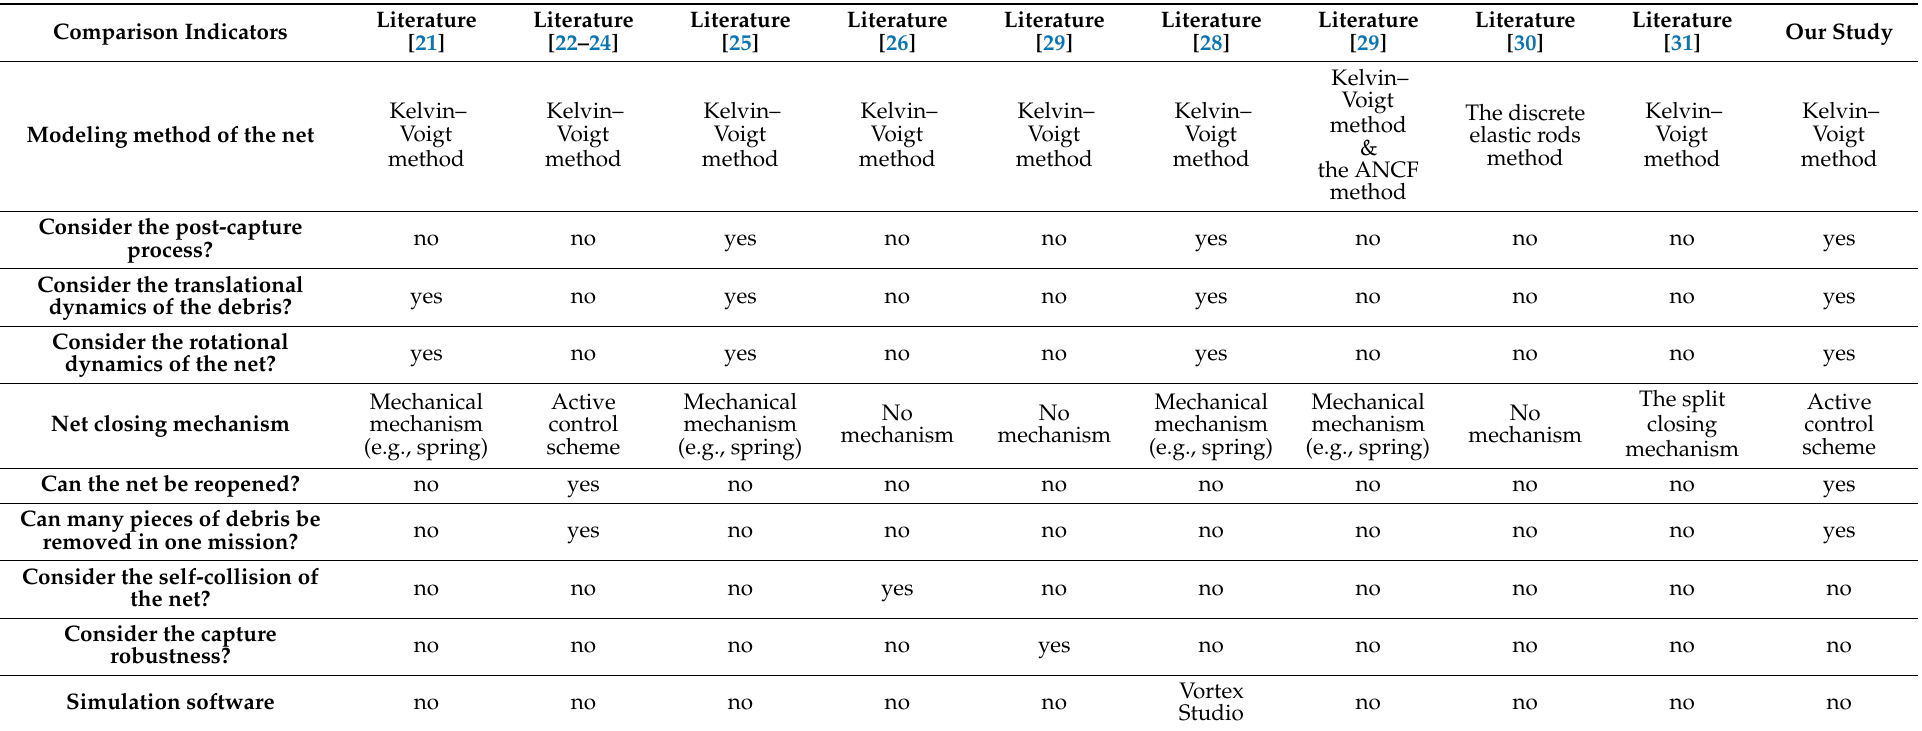
Table 1. Comparisons of the proposed method with the previous